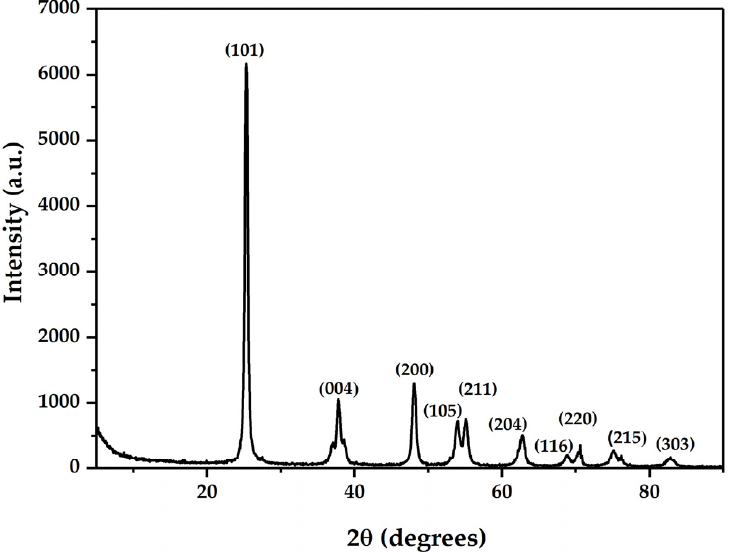
Figure 3. X-ray diffraction pattern of the Ti/TiO 2 electrode synthesized by spin coating. Most Ti/TiO 2 diffraction peaks were matched to the anatase phase corresponding to the (101), (004), (200), (105), (211), (204), (116), (220), (215), and (303) planes according to card number 211,272. The XRD pattern showed only one phase in the sample, without impurities in the crystalline